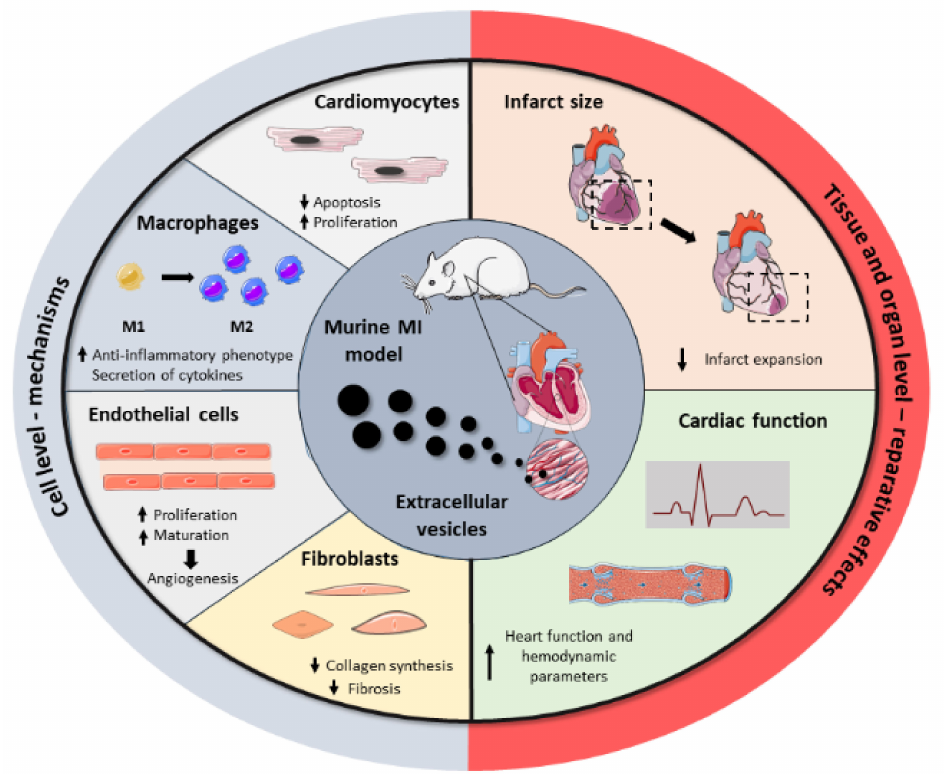
Figure 2. Summary of the beneficial effects of EVs in cardiac repair. Administration of EVs in MI preclinical models showed that EVs modulate a regenerative response in several cardiac cells, including cardiomyocytes, macrophages, endothelial cells, and fibroblasts. Together, these cell-level effects result in the reduction of infarct size and the improvement of cardiac function after